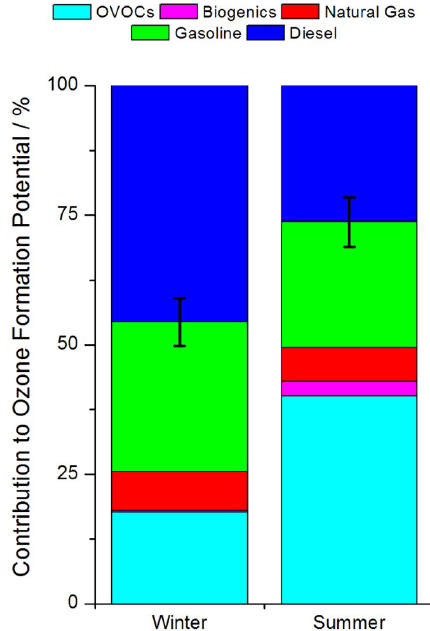
Figure 7. Contribution of emission sources to ozone formation po- tential, where diesel is representative of total diesel emissions and the error bars show the uncertainty of the unobserved diesel fraction